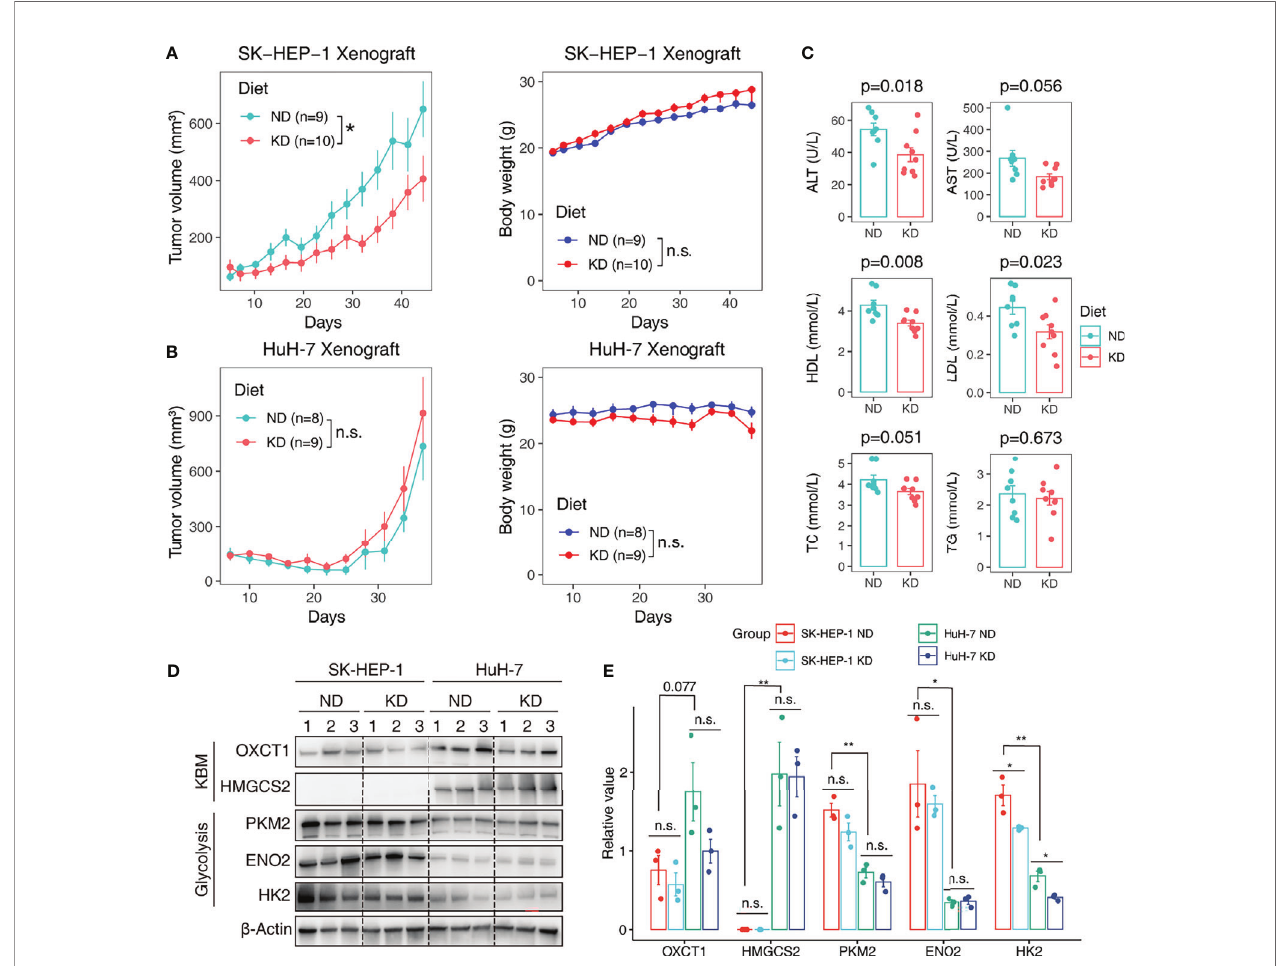
FIGURE 7 | Validating the predictive value of metabolic subtypes in KDT in HCC xenograft model. HCC cell line SK-HEP-1 (glycolytic subtype) and HuH-7 (KB- metabolic subtype) were subcutaneously inoculated into the fl ank of nude mice. The tumor-bearing mice were random allocated to the normal diet (ND) or ketogenic diet (KD) group. Tumor volumes were monitored every three days. Tumor growth curve and body weight growth curve of SK-HEP-1 (A) and HuH-7 (B) were shown. (C) The serum ALT, HDL and TC level in ND and KD group mice. (D) Western blot analysis of glycolysis and KBM enzymes in SK-HEP-1 and HuH-7 tumors. Limited by the well number of SDS PAGE, we randomly test three samples from each group. (E) Quanti fi cation of protein levels normalized onto b -actin in each condition. Data are presented as mean ± SD. Student t-test was used for statistical analysis. *p<0.05; **p<0.01; n.s., not signi fi